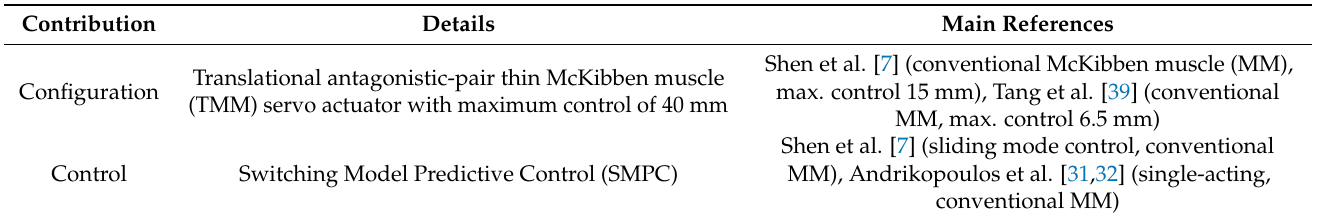
Table 1. Summary of the contributions of this